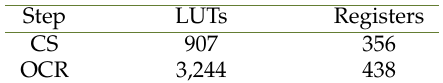
Table 3. Operation with Pipeline Resource